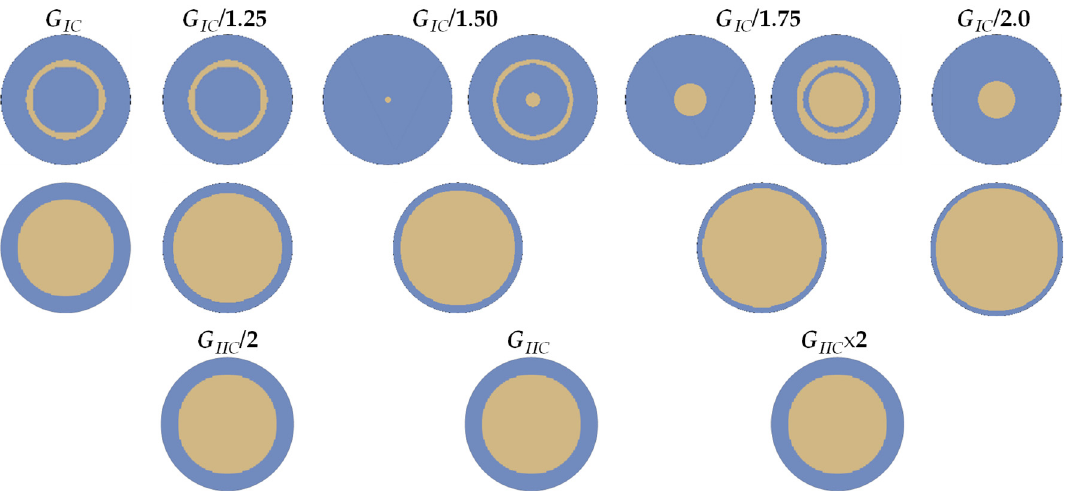
Figure 15. Predicted stripping evolution and final stripping pattern for different G IC and G IIC values. Aluminum’s thickness is 0.97 mm, epoxy’s thickness is 25 μ m, spot diameter is 4 mm and P max = 2639 MPa.